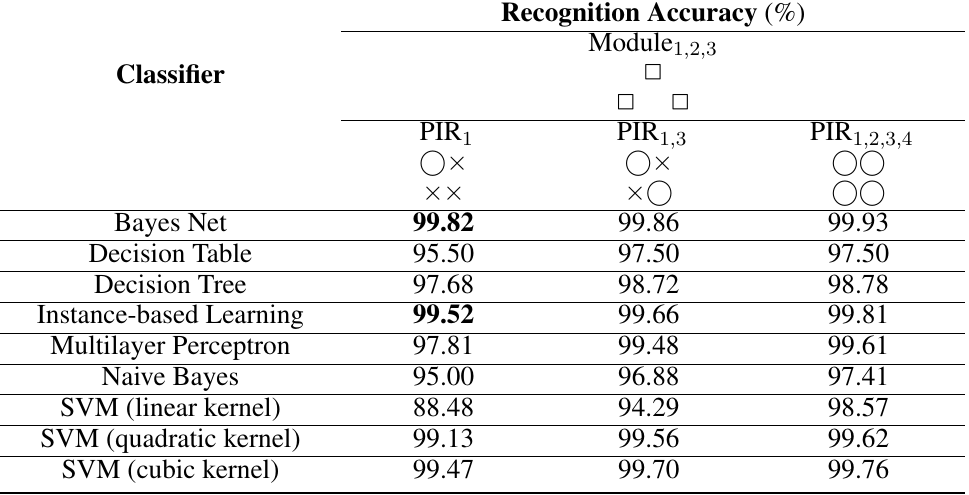
Table 3. Comparison of the recognition accuracy (%) of classifying walking distance intervals based on the raw data set with respect to the number of PIR sensors of all